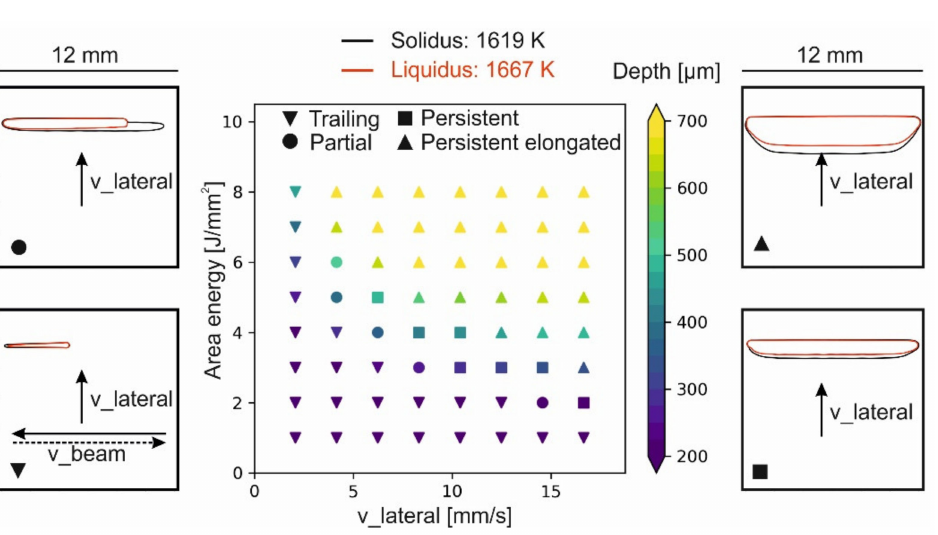
Figure 9. Simulation of the melt depth and the appearance of the melt pool as a function of the v_lateral and the area energy for a hatch distance of 100 µ m. Beam scanning direction and lateral movement as